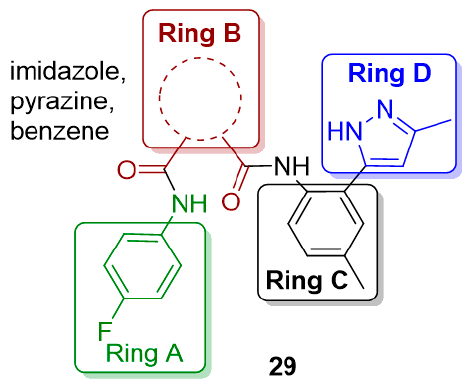
Figure 3. Structure of some conjugated compounds with anti-enteroviral activity.